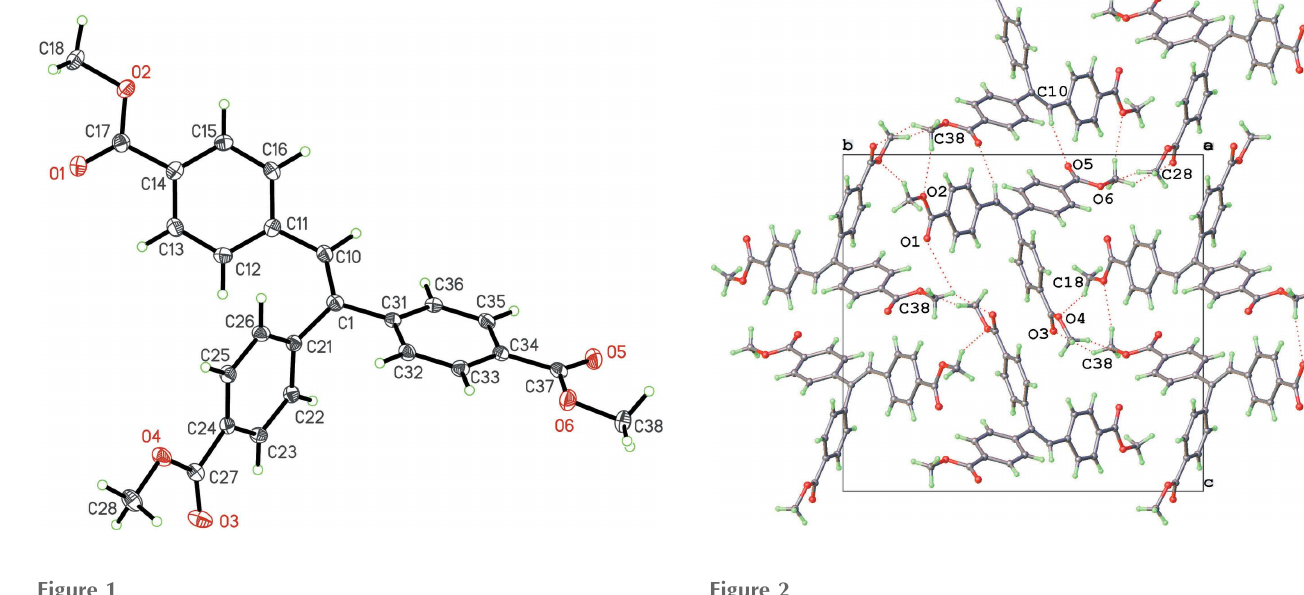
Figure 2 A view of the packing diagram showing short C—O (cid:4)(cid:4)(cid:4) H—C inter- molecular interactions.